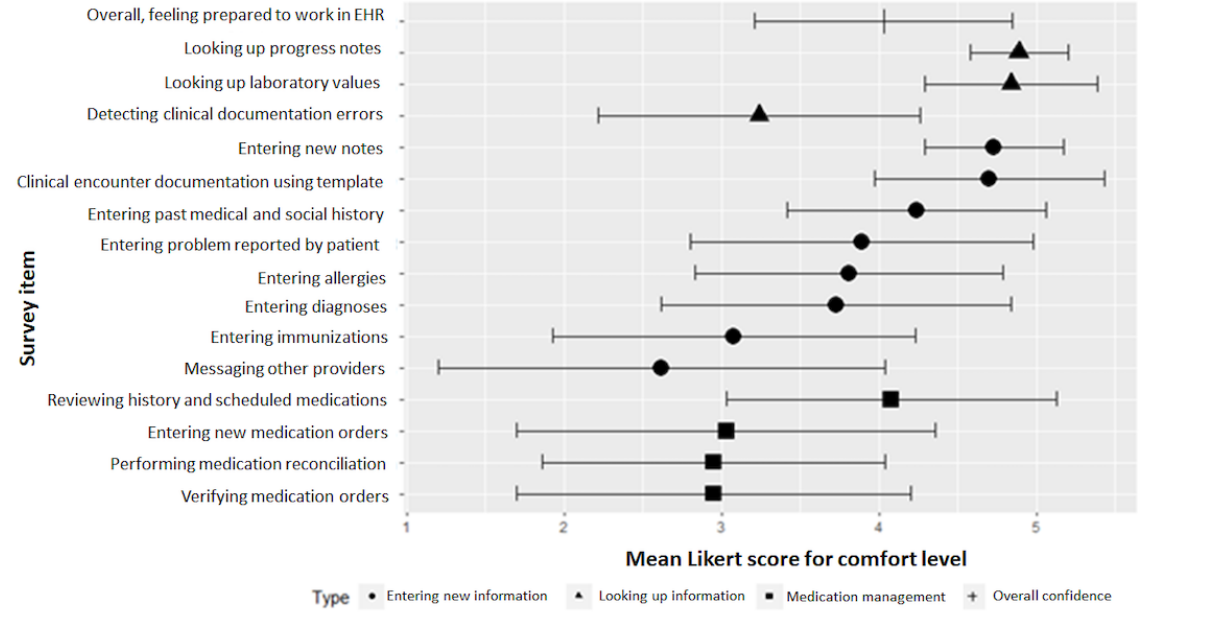
Figure 1. Mean Likert scores for comfort level with electronic health record–related tasks among senior fourth-year medical students from the University of California San Diego School of Medicine and the University of Nebraska Medical Center College of Medicine, 2019. EHR: electronic health record. Error bars indicate standard